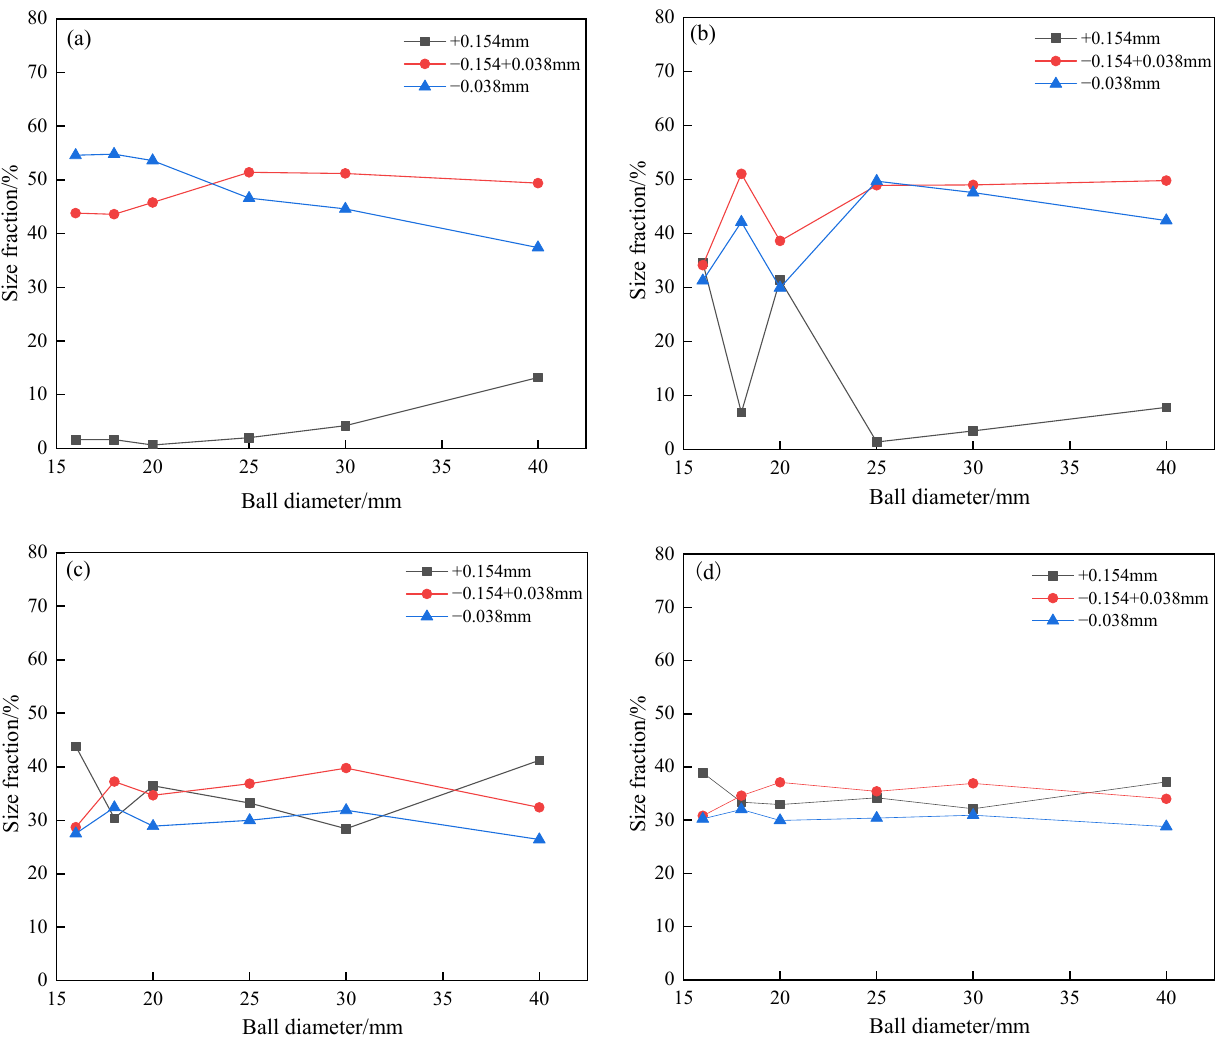
Figure 2. Plots of the yields of the product size fractions against the ball size at ball filling fractions of ( a ) 30%, ( b ) 35%, ( c ) 40%, and ( d ) 45%.